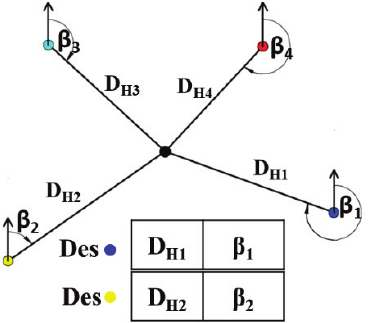
Figure 4. The Feature Descriptors w.r.t origin (example shown is the distance and angle of orange circle point to the origin of the system)